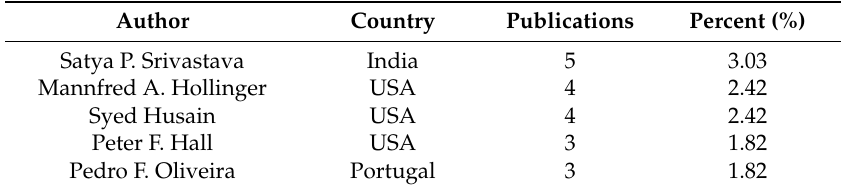
Table 2. The 5 most productive authors for publications of effects of xenobiotics on glucose metabolism in